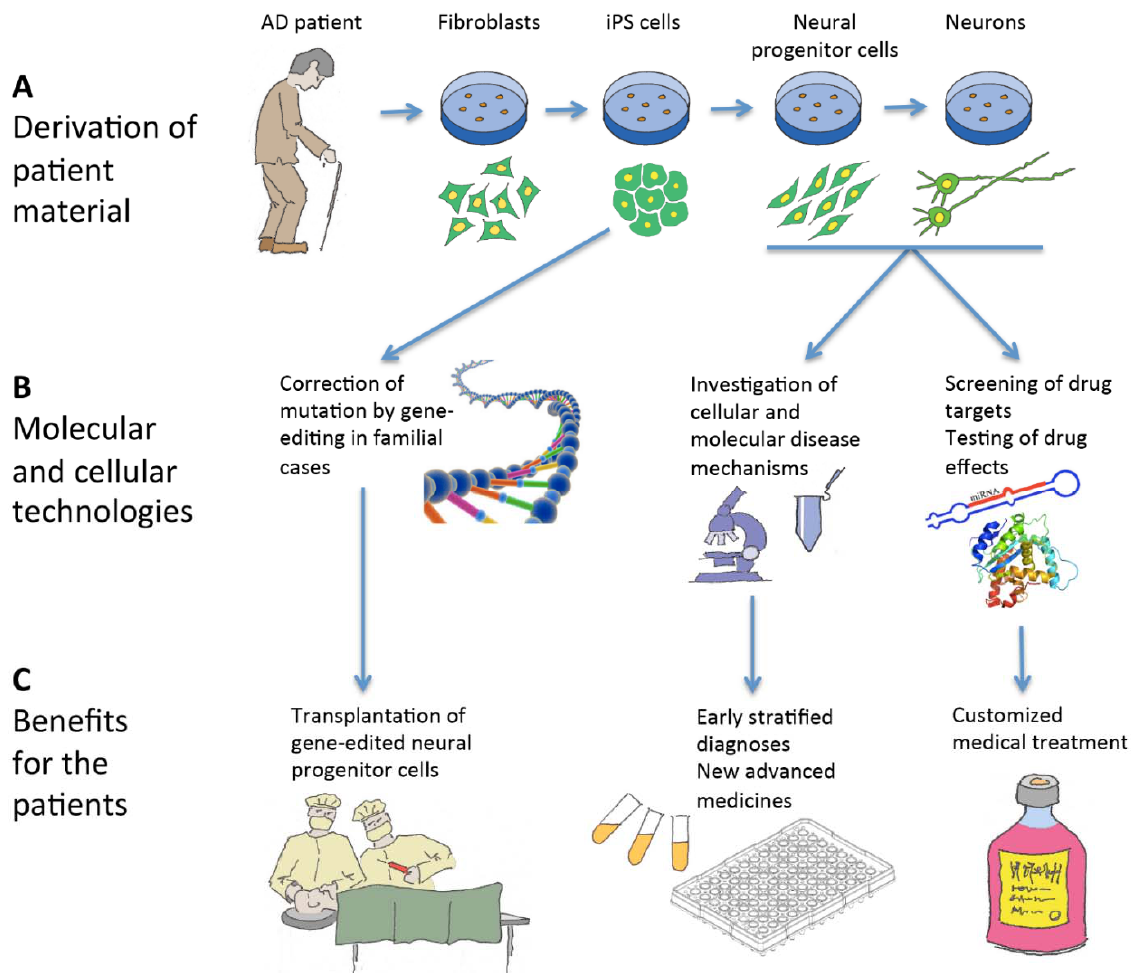
Figure 1. Schematic illustration of the use of induced pluripotent stem (iPS) cells in relation to Alzheimer’s disease (AD). ( A ) iPS cells are derived from a skin biopsy from an AD patient and differentiated into neural progenitor cells and neurons; ( B ) In familial cases, the disease-causing mutation can be corrected by gene-editing of the iPS cells, and neural progenitor cells and neurons can be used for research and drug screening; ( C ) The patients can in the long run benefit from these activities by cell therapy, better diagnostic procedures, customized treatments and novel medical